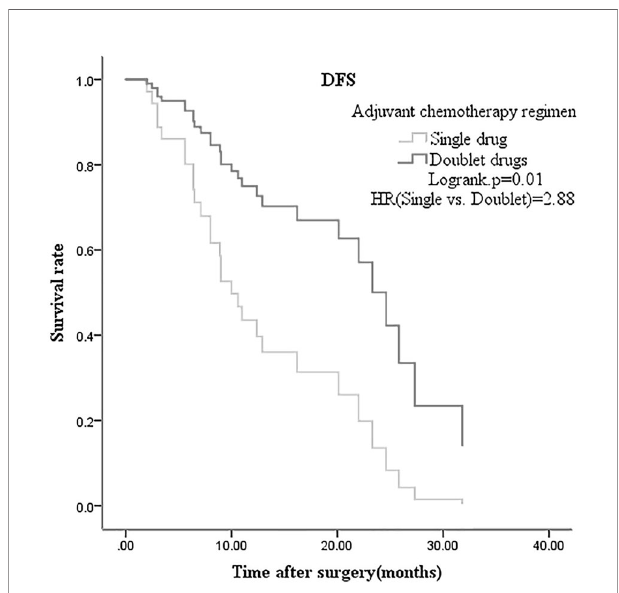
FIGURE 1 | Disease free survival multivariate analysis of radical postoperative cholangiocarcinoma grouped by adjuvant chemotherapy.